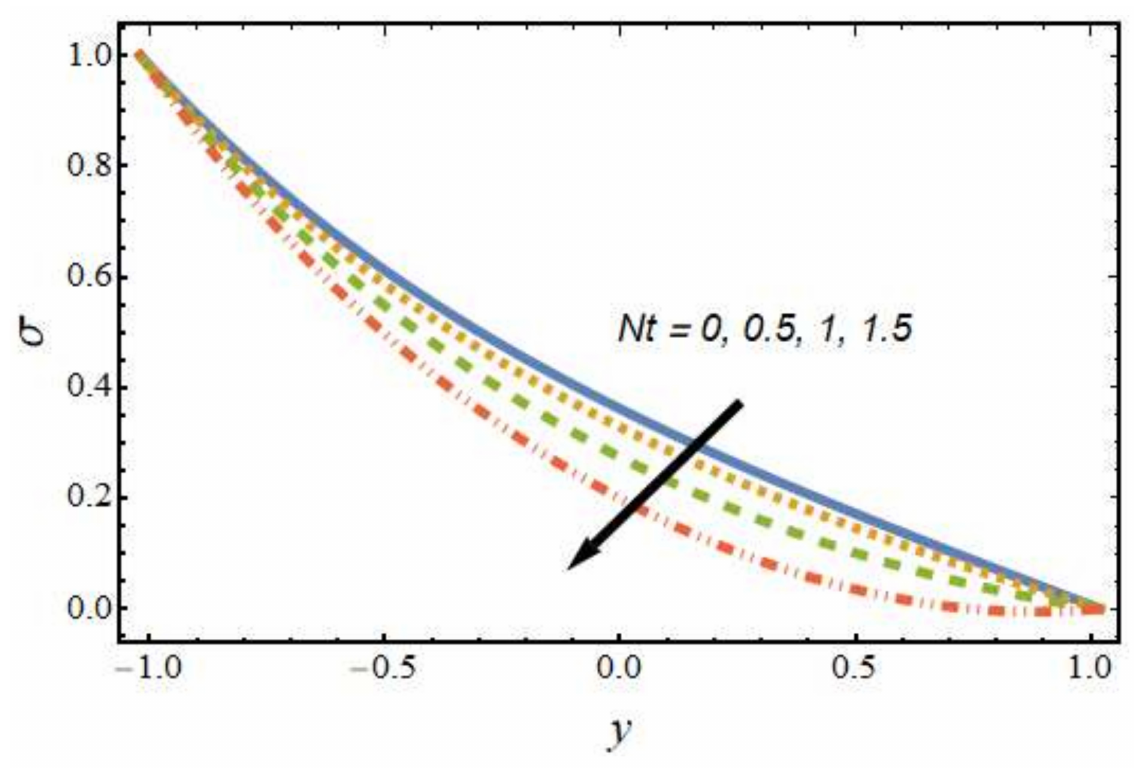
Figure 13. Nanoparticle concentration profile for various values of the thermophoresis